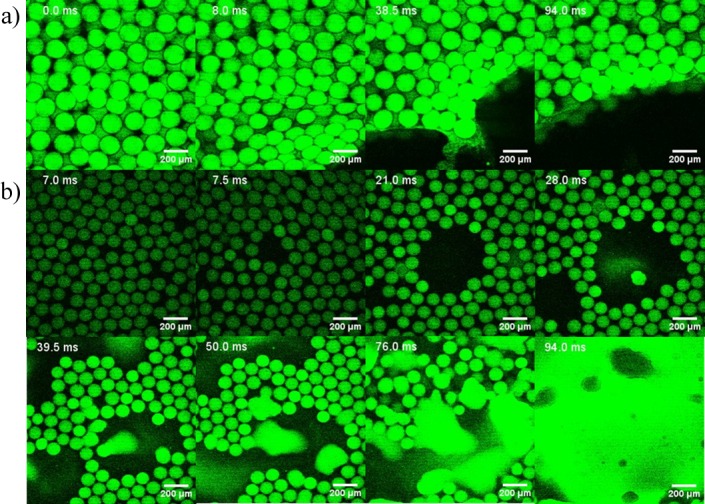
Confocal images showing pH responsive behaviour.Time lapse snapshots (in milliseconds, ms) of carboxyfluorescein (50 μM) encapsulated particles composed of 5% (w/v) Eudragit® S100 (Formulation D2, Table 1). a) exposure of ~170 μm particles to 0.1M HCl; b) dissolution of ~170 μm particles in 0.1M NaOH. Snapshot time series in milliseconds (ms).